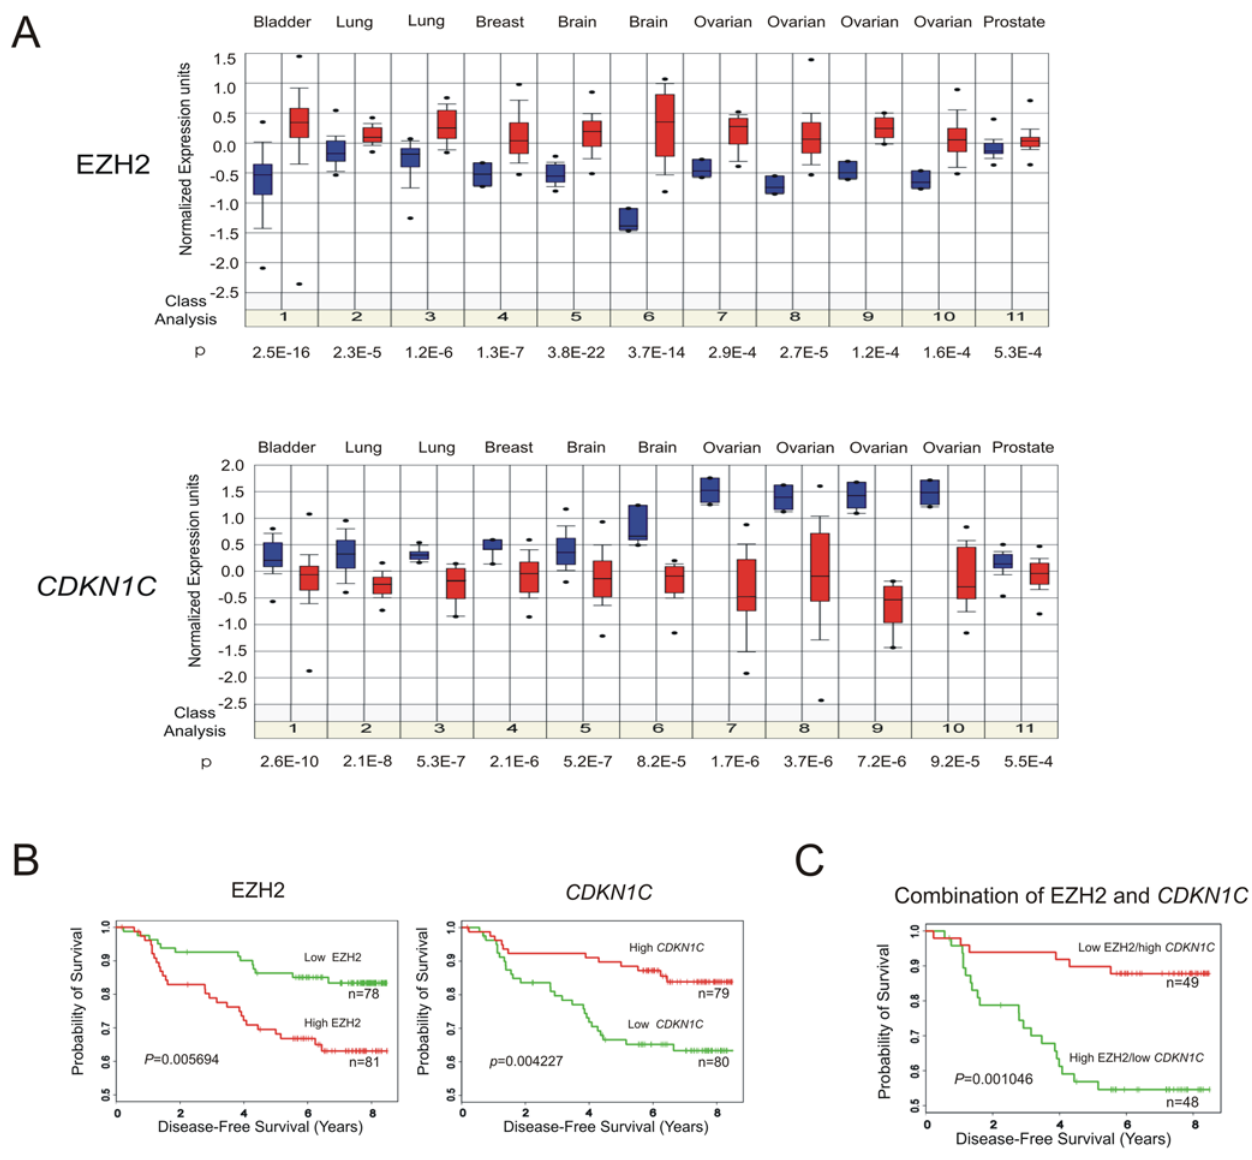
Figure 6. Levels of CDKN1C expression predict the clinical outcome of breast cancer patients. (A) Upregulation of EZH2 and downregulation of CDKN1C expression are shown in multiple cancer types with indicated P values by comparing the tumor (red) and the adjacent normal (blue) tissues. The data is extracted from Oncomine microarray database (www.oncomine.org). Breast cancer patients were ranked according to different levels of EZH2 or CDKN1C as described in Methods. (B) Kaplan-Meier survival plots of disease-free survival (DFS) from Stockholm cohort (Miller, et. al., GEO ID GSE3494). Patients with higher EZH2 or C DKN1C expression are highlighted in red, while patients with lower EZH2 or CDKN1C expression are highlighted in green. (C) Kaplan-Meier survival plots of disease-free survival (DFS) from Stockholm cohort. Patients with higher EZH2 but lower C DKN1C are highlighted in green, while patients with lower EZH2 but higher CDKN1C are highlighted in red.